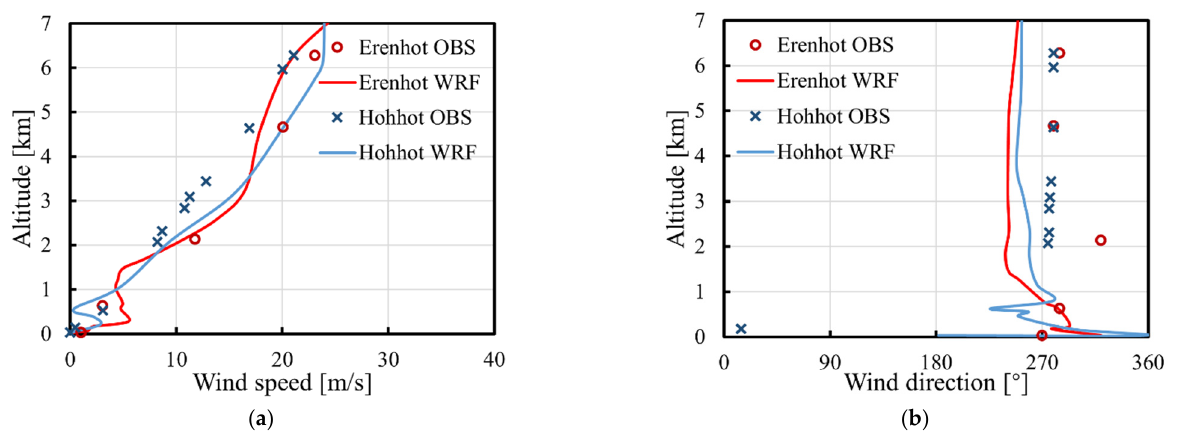
Figure 4. Profiles of ( a ) wind speed and ( b ) wind direction above the main landing area from WRF and upper-atmosphere sounding data at 00:00 LST on 17 October 2005.